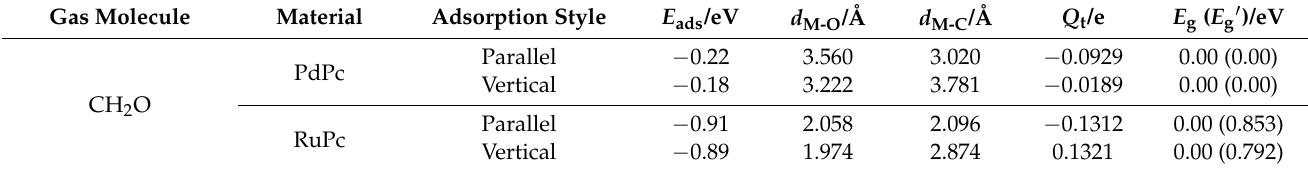
Table 2. The adsorption energy ( E ads ), adsorption distances ( D ), charge transfer ( Q t ), and band gap of the system before adsorption ( E g ) and after adsorption ( E g (cid:48) ) of CH 2 O@PdPc and CH 2 O@RuPc adsorption